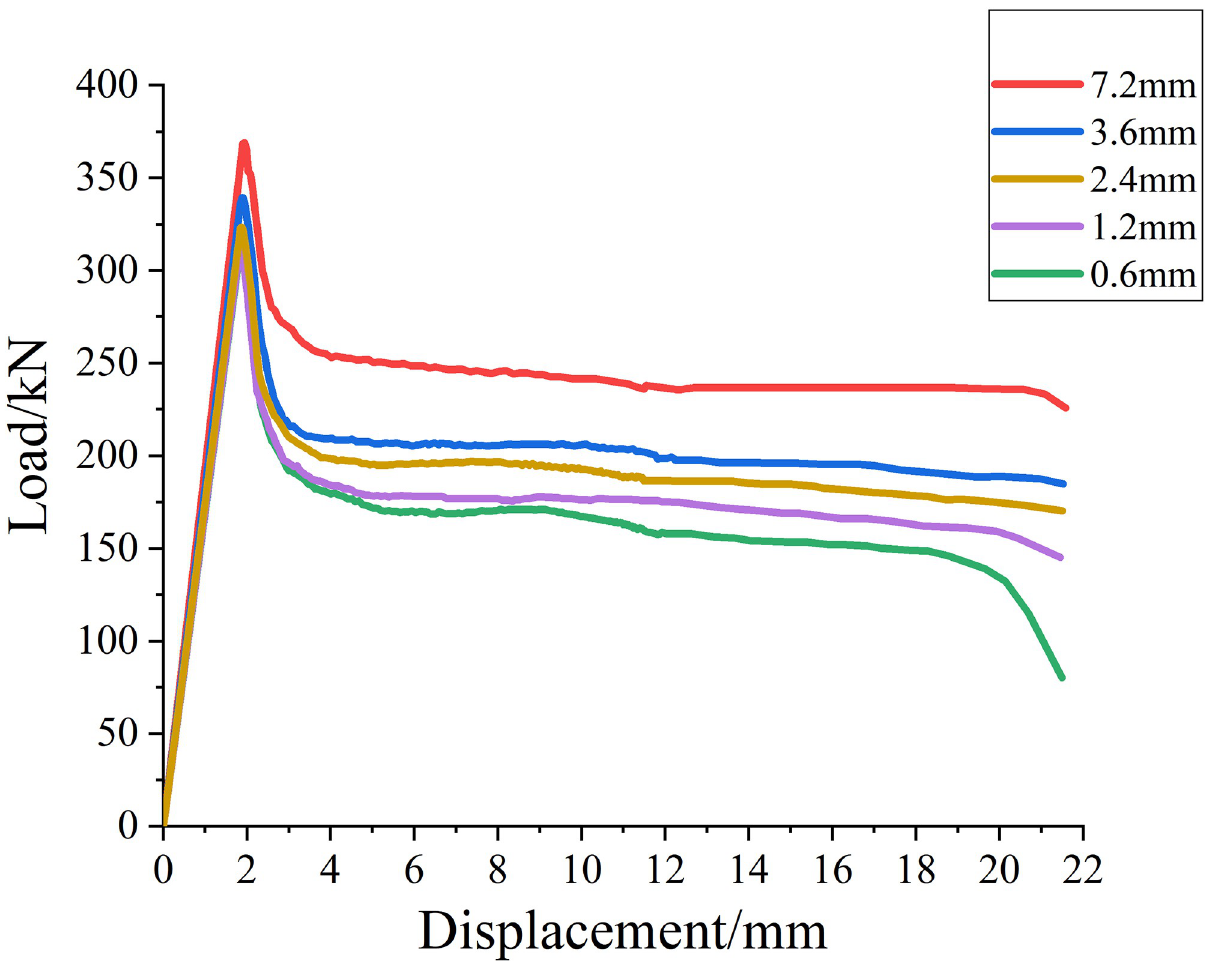
Fig 18. Load-displacement curves of reinforcement parts with different diameter of SMA wires.